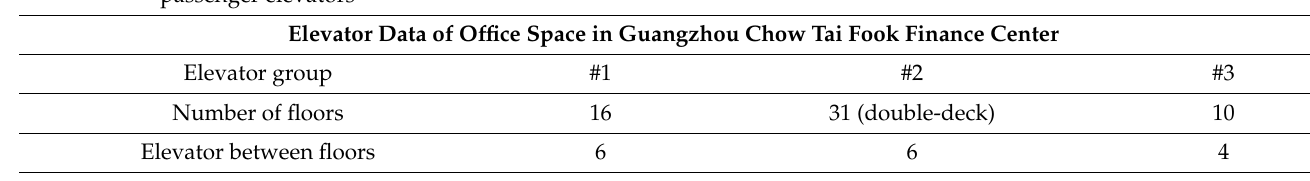
Figure 15. Elevator shaft area of the typical floor.